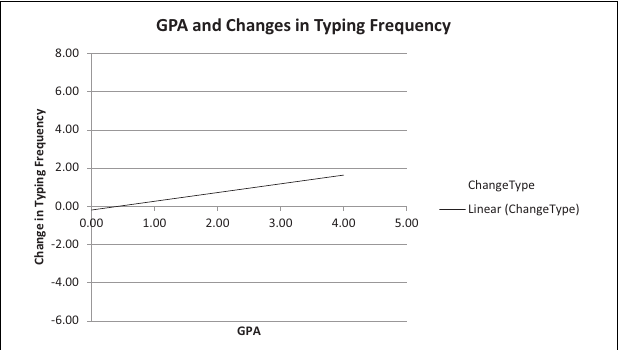
FIGURE 2 | A linear relationship between GPA and typing frequency change following commencement of the COVID-19